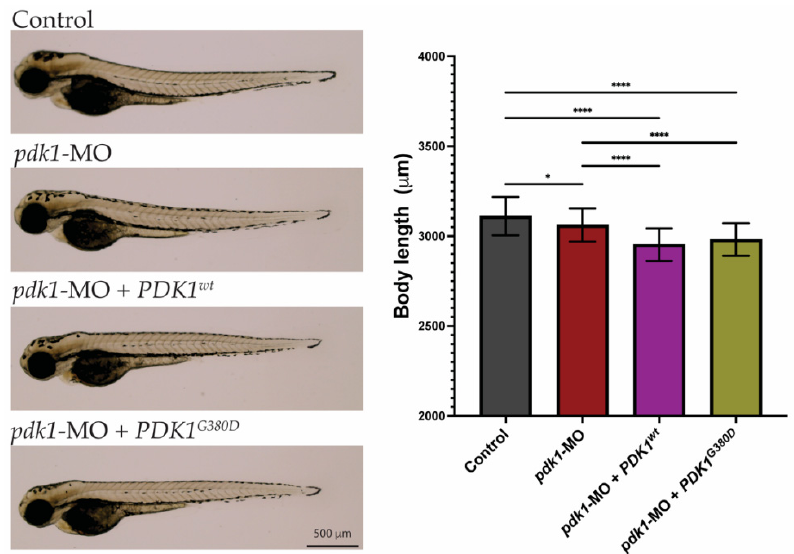
Figure 2. Morphology of zebrafish embryos. Three-days-old embryos from all experimental groups were photographed and show no major phenotypes. Quantification of total body length showed embryos from the experimental groups were significantly smaller than those from the control group (n = 50–75 embryos per group, * p < 0.026, **** p < 0.0001).